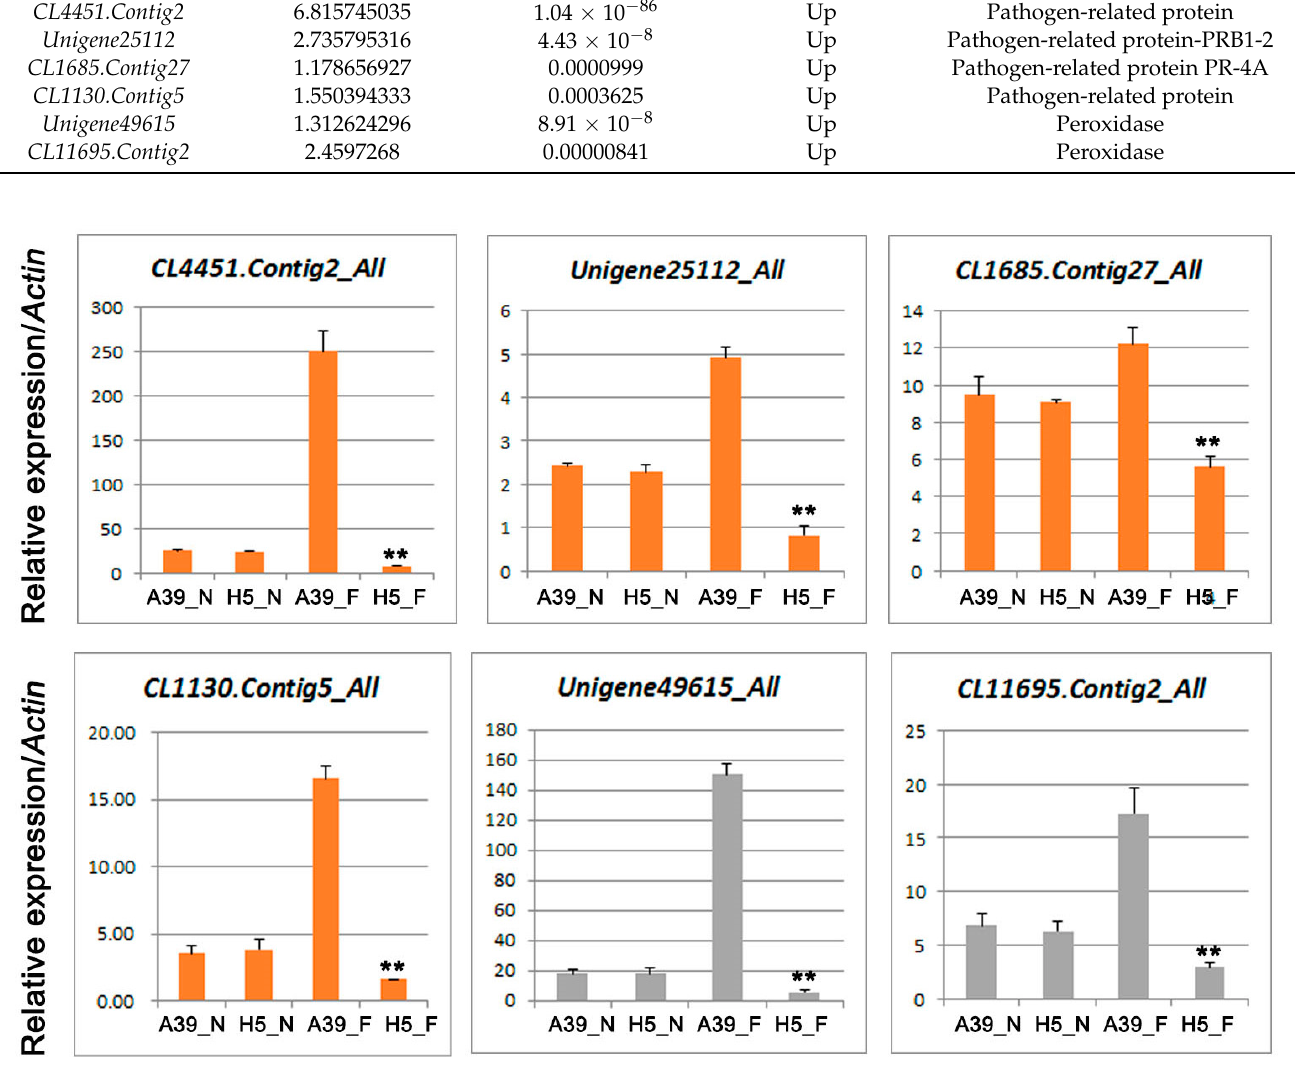
Table 1. Genes related to pathogen-related protein.